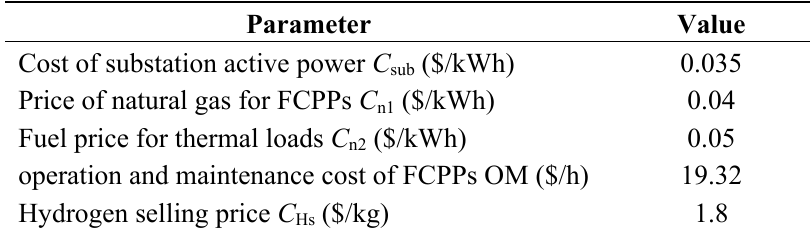
Table 2. Information of cost parameters.